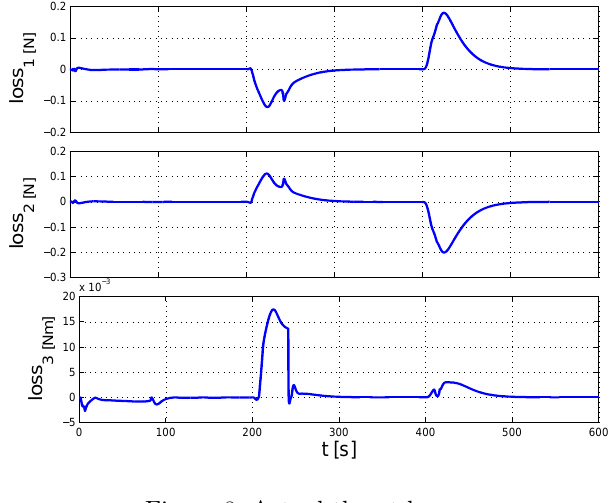
Figure 8: Actual thrust